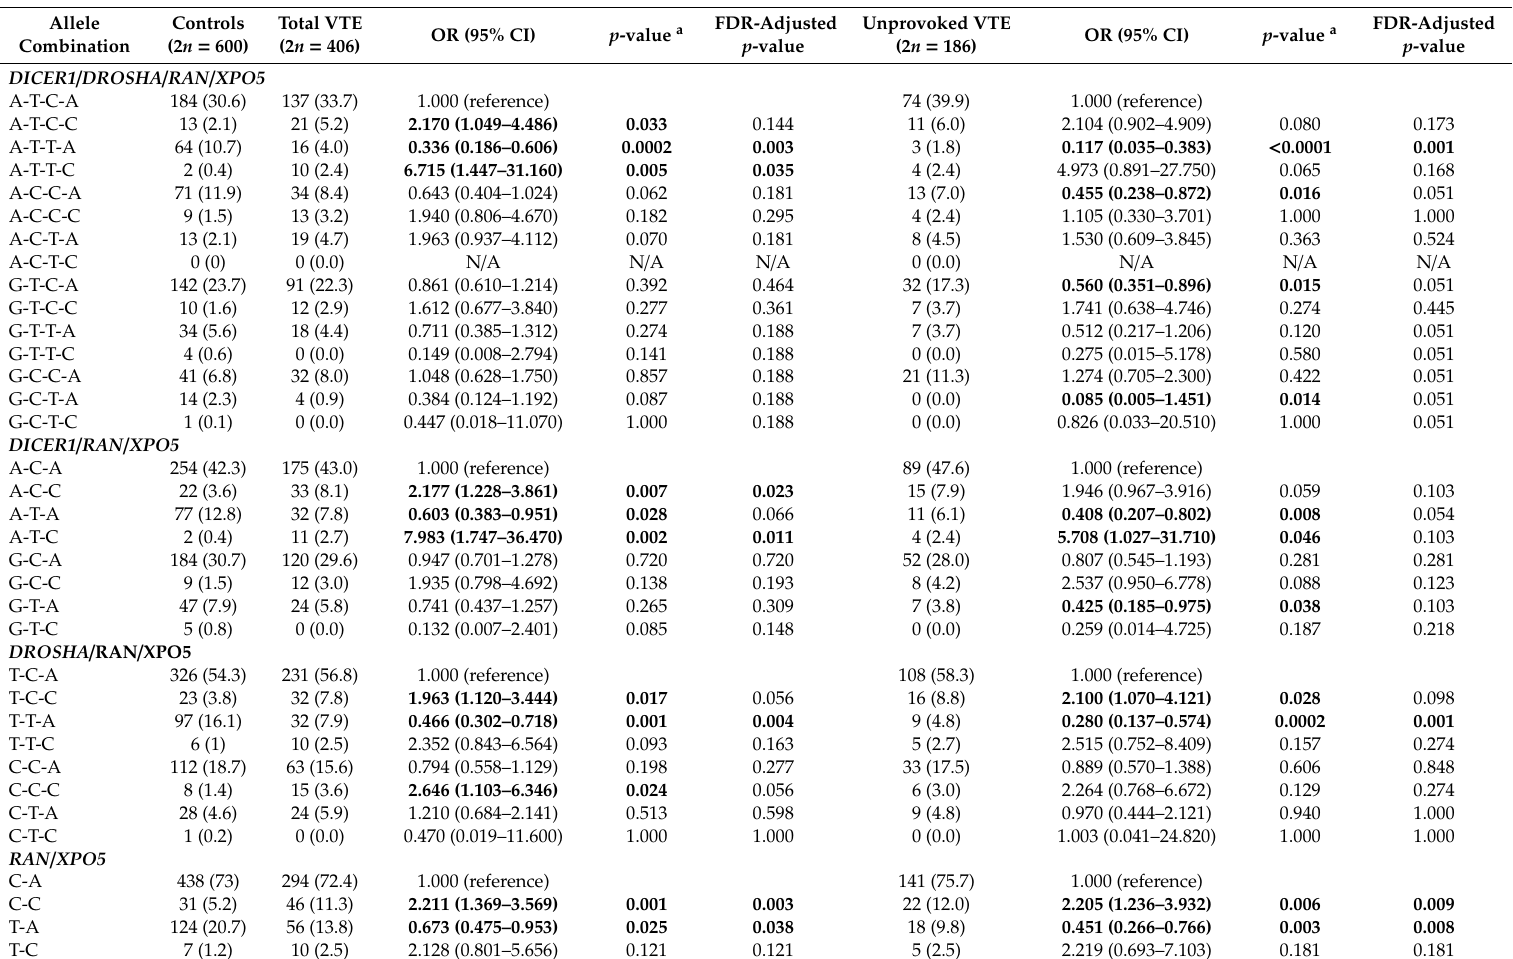
Table 4. Allele combination analysis of the DICER1 , DROSHA , RAN , and XPO5 gene polymorphisms in VTE patients and